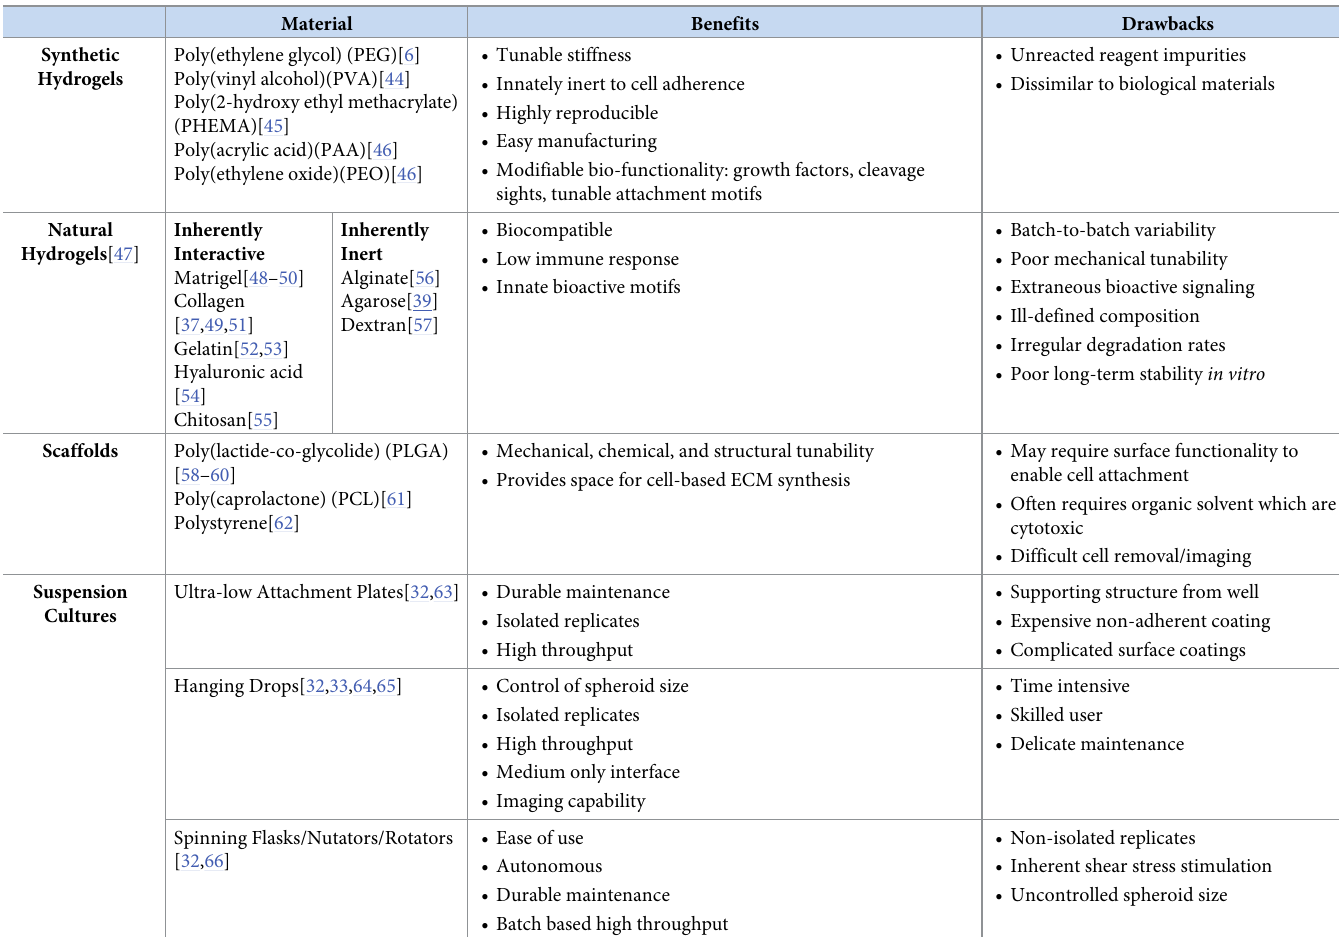
Table 1. Summary of 3-dimensional cancer bioengineering methods and their respective benefits and